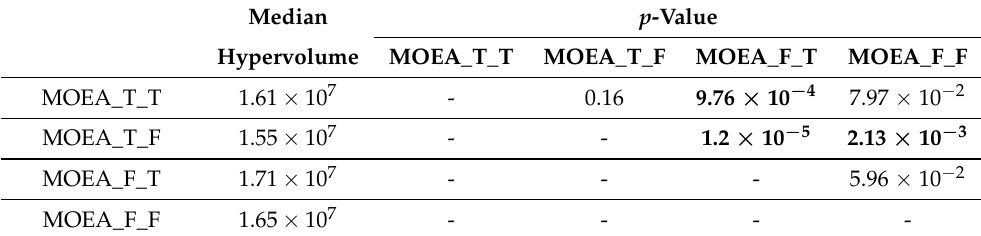
Table 2. Results for the multi-objective case of Experiment 1 (variants = false vs. variants = true) and Experiment 2 (cooling = false vs. cooling = true). The median of the set of 100 hypervolume values is presented for each method plus the p -values calculated pairwise with the Wilcoxon rank-sum test. The best values are highlighted in